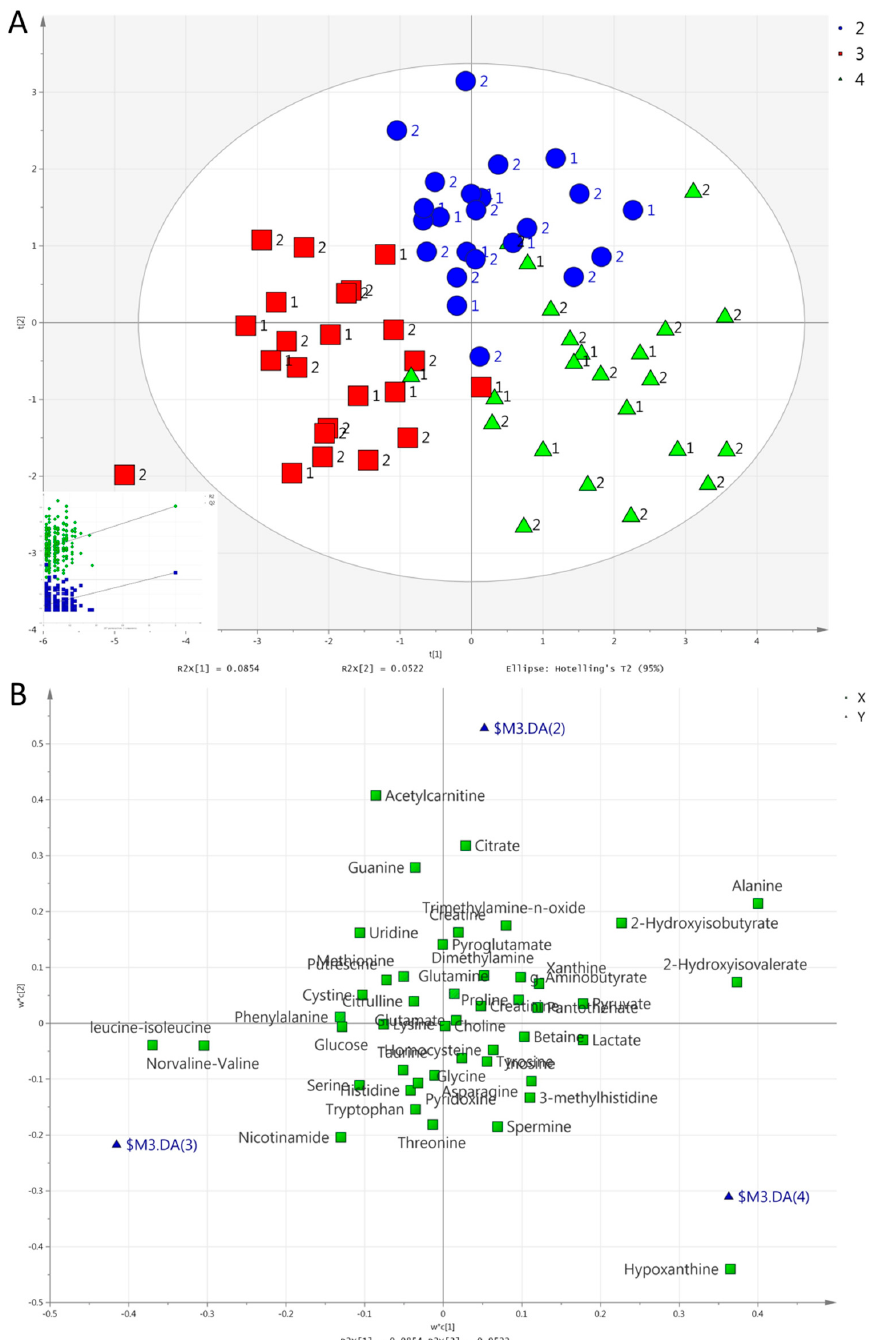
Figure 4. ( A ). Score plot concerning serum samples for the PLS-DA model comparing exercise modes at 2 h: HIIE (blue circles), CME (red squares), RE (green triangles). Inserts (subfigure) are permutation plots. The number 1 is used for the MetS group and 2 for the Healthy group. ( B ). Loading plot for the respective PLS-DA model. Blue triangles represent HIIE (2), CME (3), and RE (4). Valid models also separated all three time points for HIIE and RE (Figures 5 and 6, respectively), but not for CME. Pairwise separation by time was achieved for HIIE between 0 and 1 h; 0 and 2 h;